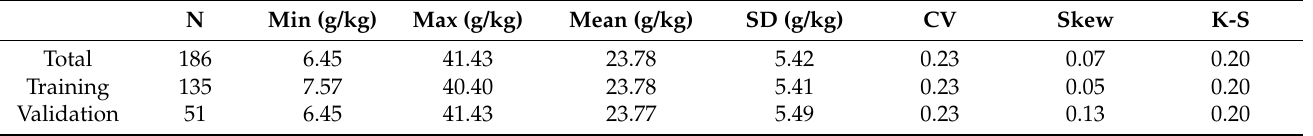
Table 5. Basic descriptive statistics of the total, training and validation datasets for SOC.